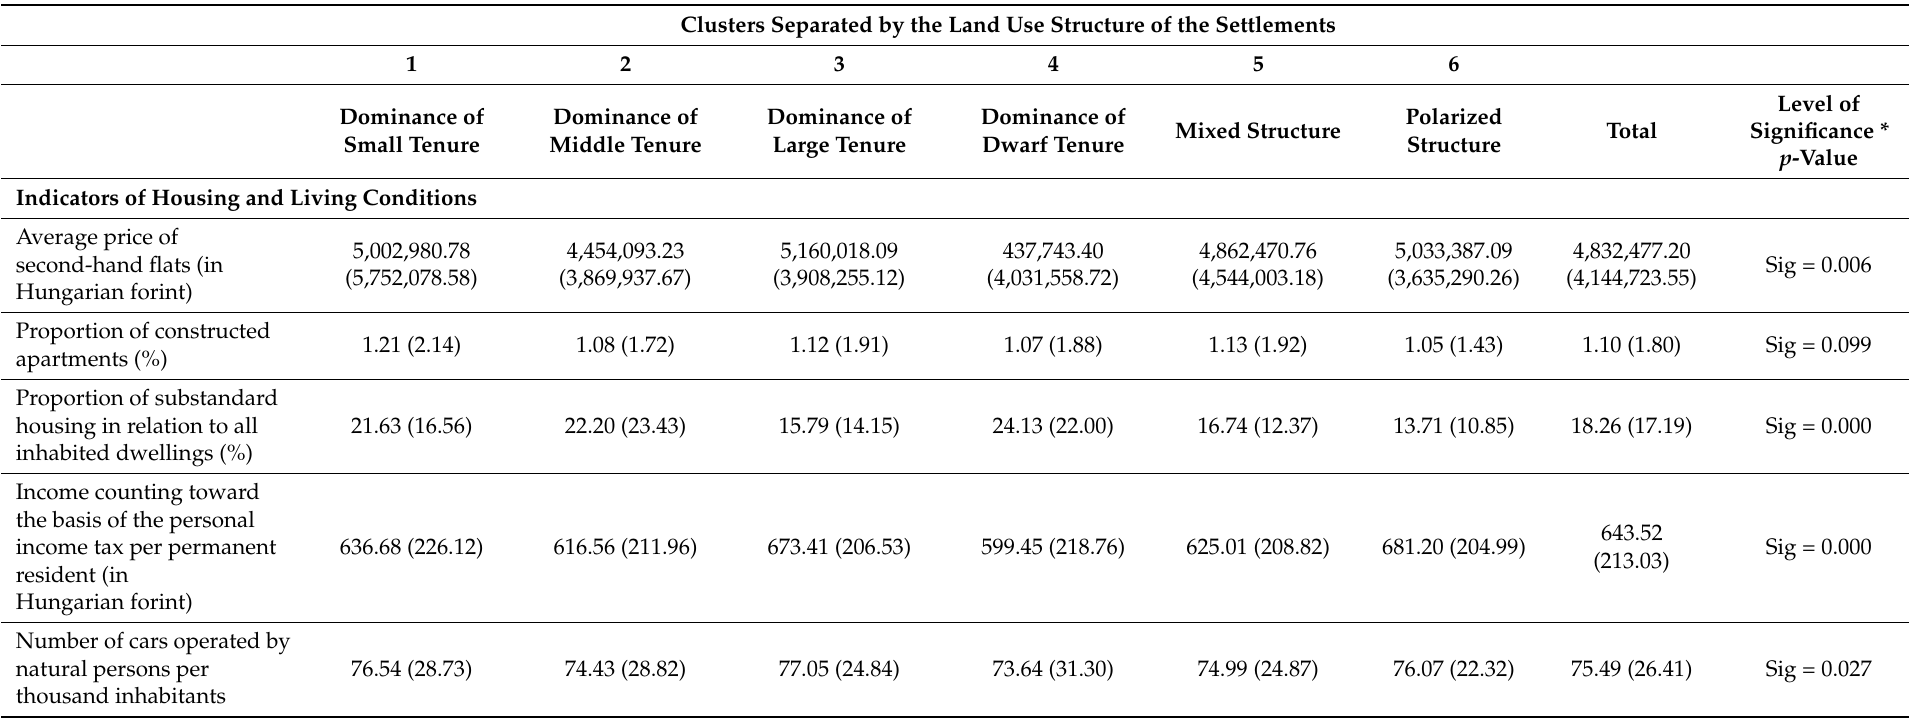
Table A3. Deviation of the six settlement clusters according to the indicators of housing and living conditions, average values (standard deviations in brackets). Clusters Separated by the Land Use Structure of the Settlements 1 2 3 4 5 6 Level of Dominance of Dominance of Dominance of Dominance of Polarized Mixed Structure Total Significance * Small Tenure Middle Tenure Large Tenure Dwarf Tenure Structure p